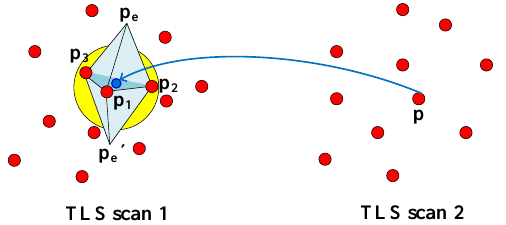
Figure 8. The representation of ICPP registration